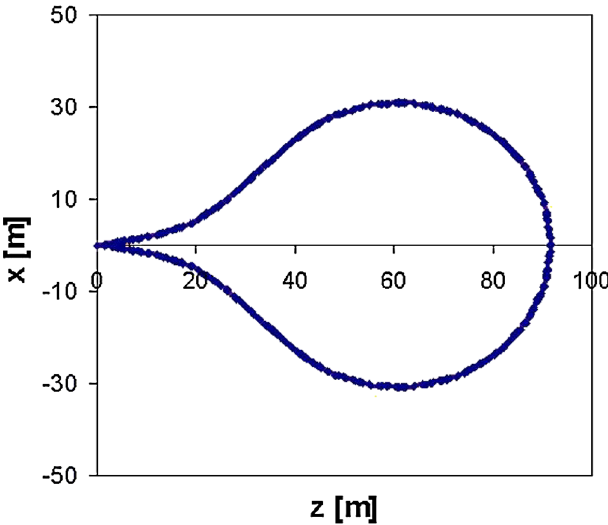
FIG. 10. (Color) Horizontal layout of a droplet arc. The outward bending 60 deg arc is followed by a 300 deg inward bending arc, and closed with another outward bending 60 deg